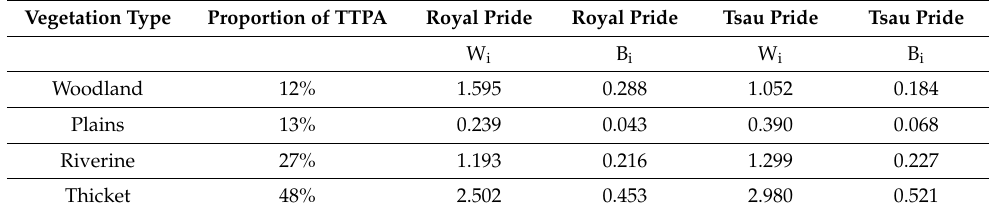
Table 7. Habitat selection by the Royal and Tsau prides at Tula-Tsau Protected Area (TTPA), South